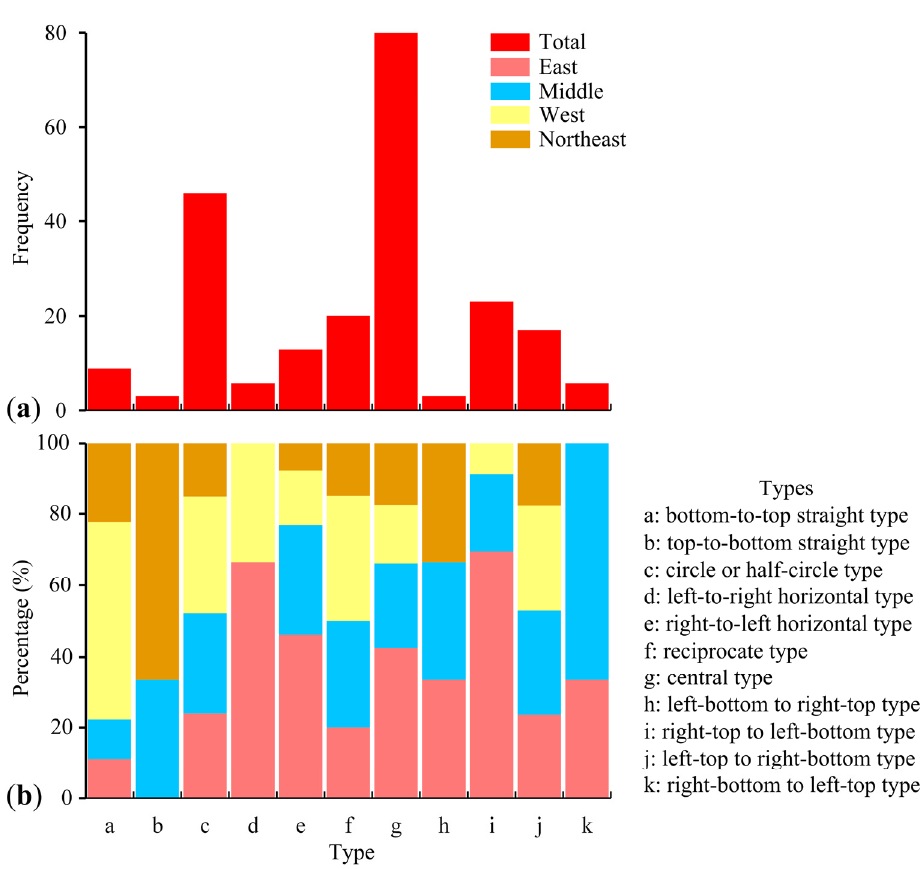
Figure 9. ( a ) Total frequency of urbanization process patterns of China’s cities. ( b ) Distribution of urbanization process patterns in east, middle, west and northeast